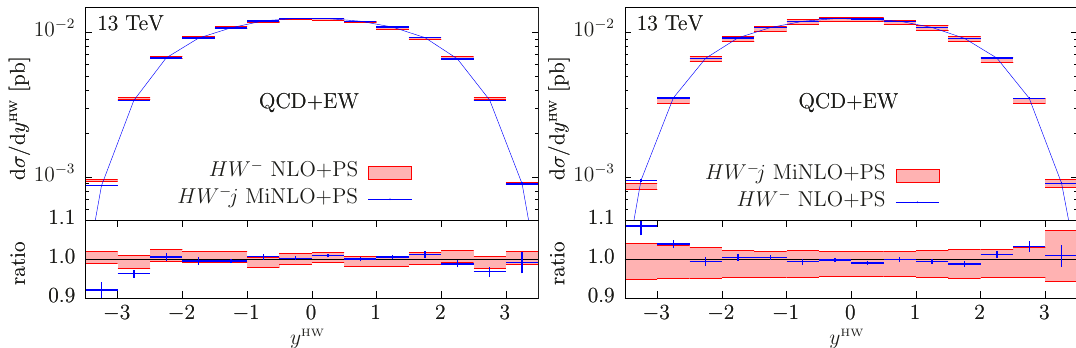
Figure 25. Comparison of NLO+PS and MiNLO +PS predictions for the distributions in the rapidity of the HW (cid:0) system in HW (cid:0) production. Corrections at NLO QCD+EW are included throughout. The red band is the envelope of the seven-point scale variations for the NLO+PS simulation, in the left panel, and for the MiNLO +PS one, in the right panel. The lower panels show the ratio plot with respect to the central-scale value of the band.